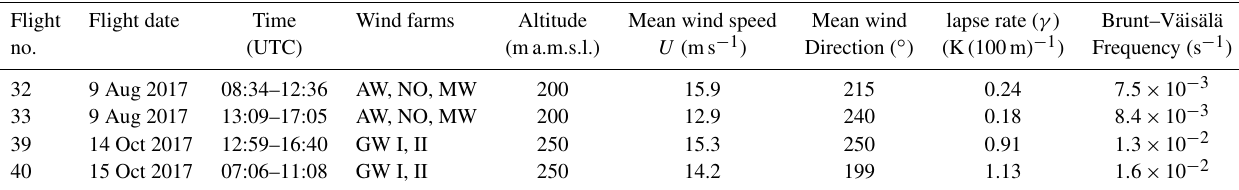
Figure 1. (a) Geographical location of the wind farm clusters where measurements were recorded in the WIPAFF campaign. FINO 1 and FINO 3 met masts locations are also shown. Wind farms operational during the WIPAFF campaign are shown here only. (b) Stability rose measured at FINO 1 met mast for years 2016 and 2017 as a function of wind direction. The units of lapse rate γ are [Km − 1 ]. This plot is reproduced here from Platis et al. (2022) with the permission from authors. Table 1. Details of the four flights operated upstream, above, and downstream of offshore wind farms analyzed in this study. The flight num- bers represent the numbers given in the WIPAFF campaign. The abbreviations used for wind farms are AW (Amrumbank West), NO (Nordsee Ost), MW (Meerwind Süd), and GW (Godewind).